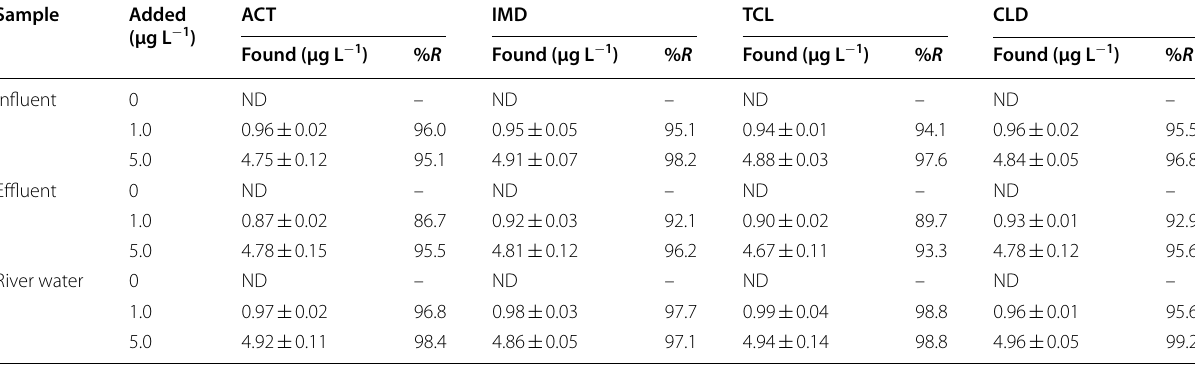
ND Not detected